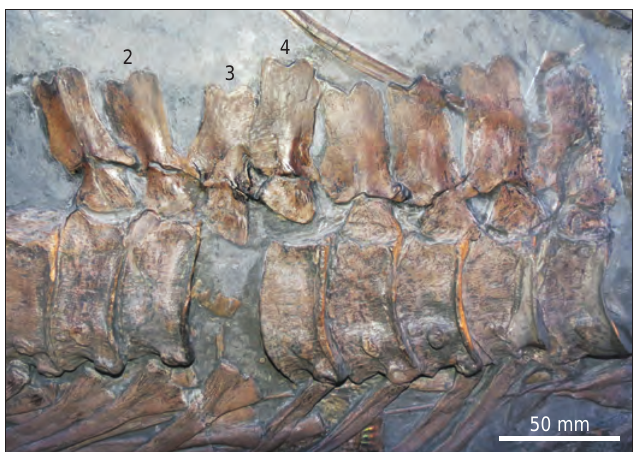
Fig. 5. Close-up of some mid-posterior dorsal vertebrae of Ichthyosaurus somersetensis Lomax and Massare, 2017 (NLMH 106234) from the Lower Jurassic (lower Hettangian) of Doniford Bay, Watchet, Somerset, UK; showing the unusual V-shape morphology of the neural spine apices. Note, the second, third, and fourth neural spine from the left are mostly reconstructed and the morphology is not